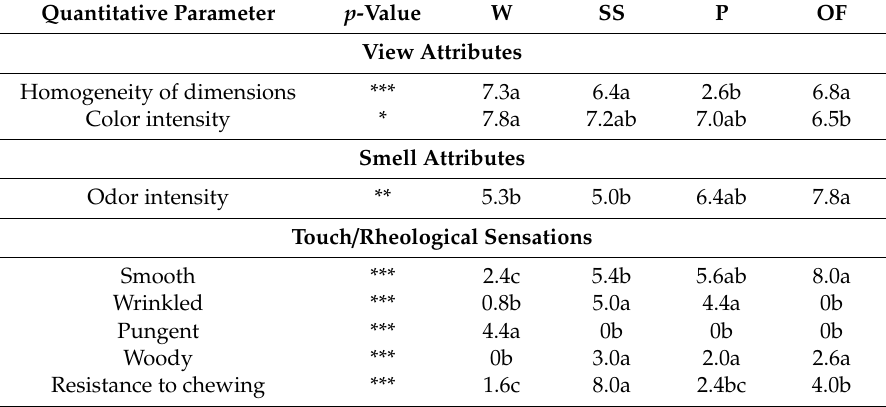
Table 4. Two-way ANOVA calculated for all quantitative and hedonic parameters evaluated by panelists during tasting sessions for Sanguisorba minor . Only data that showed significant di ff erences ( p < 0.05) are reported. Means keyed with a di ff erent letter are significantly di ff erent for p = 0.05, considering each species independently and following one-way ANOVA, with wild-collection or the di ff erent domestications as the variability factor. Significance level: ***: p < 0.001 (F = 7.94); **: p < 0.01 (F = 4.77); *: p < 0.05 (F =